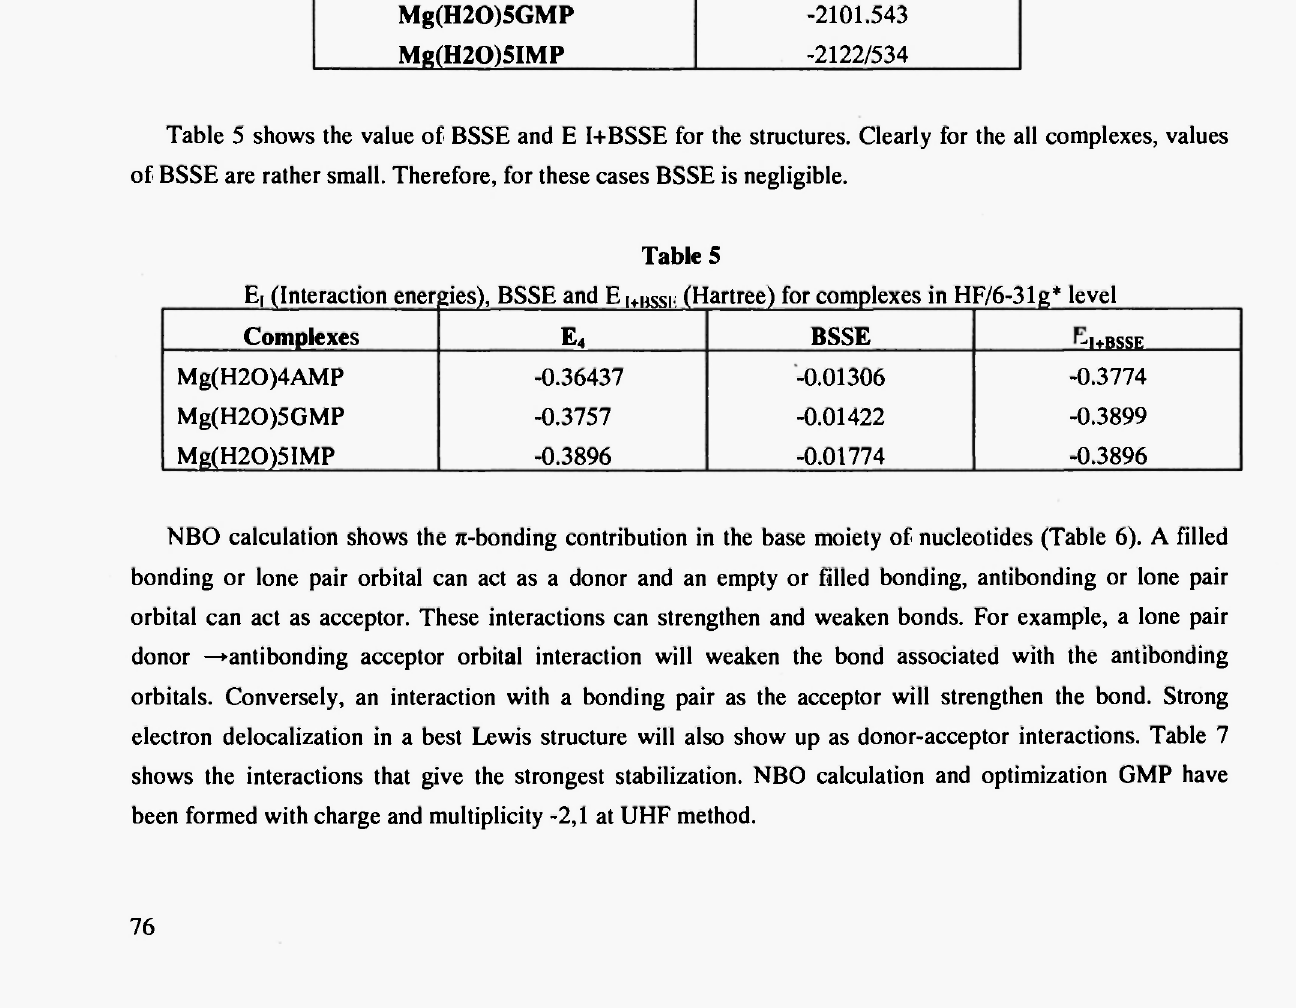
Stability energies(Hartree) for Mg-Purine nucleotide complexes in gas phase